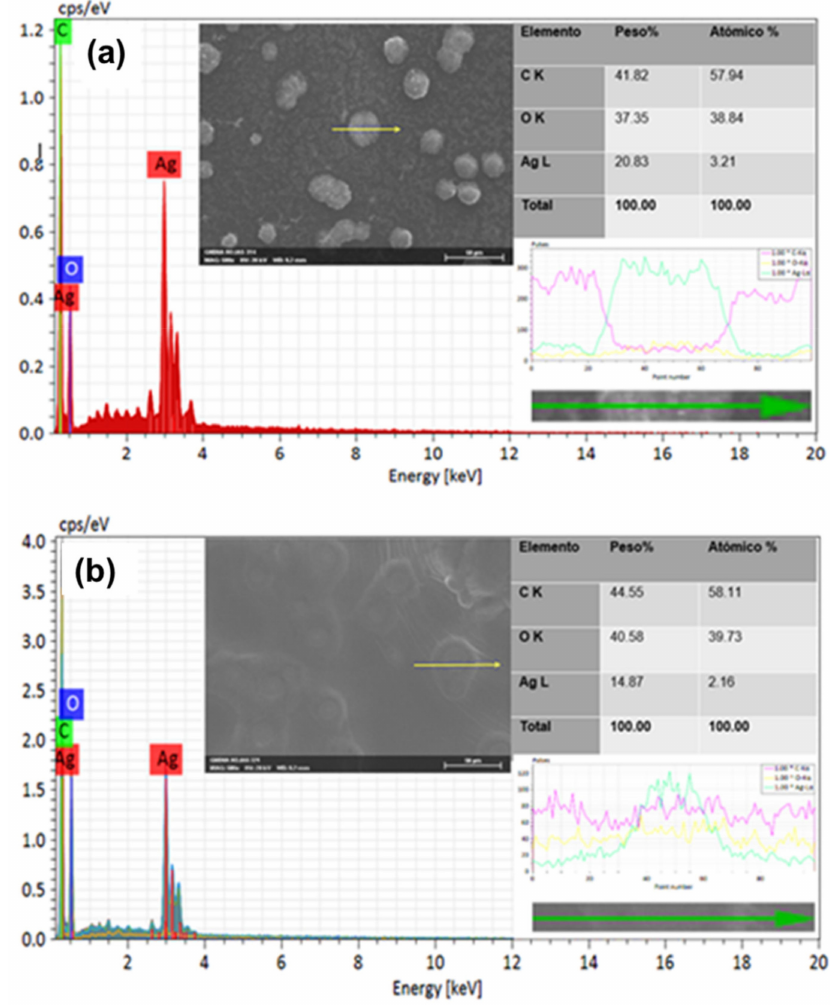
Figure 2. EDS analysis: comparison of the graphs of elementary analysis and cross-line scanning of